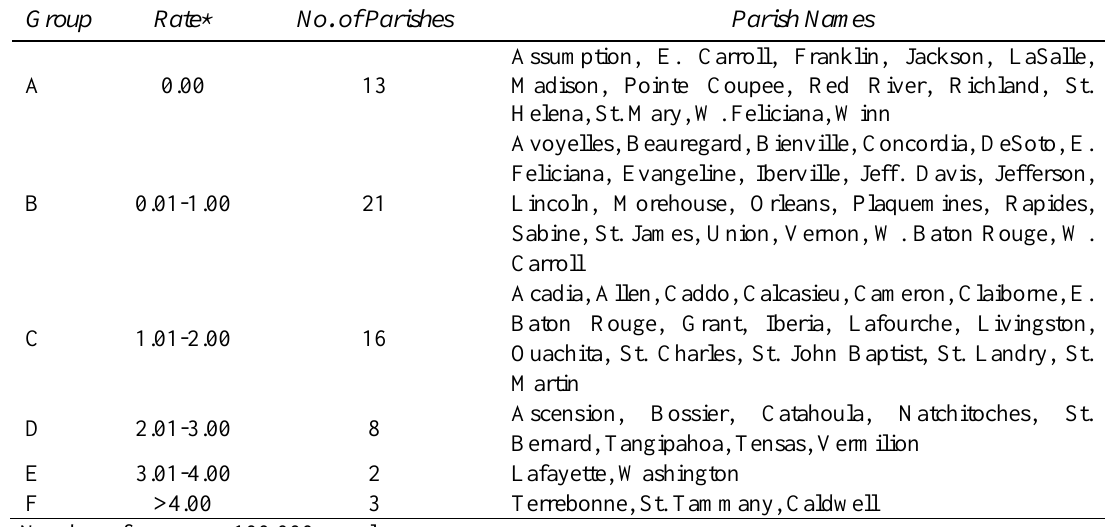
Table 7: Distribution of salmonella in various parishes for the year 2000.